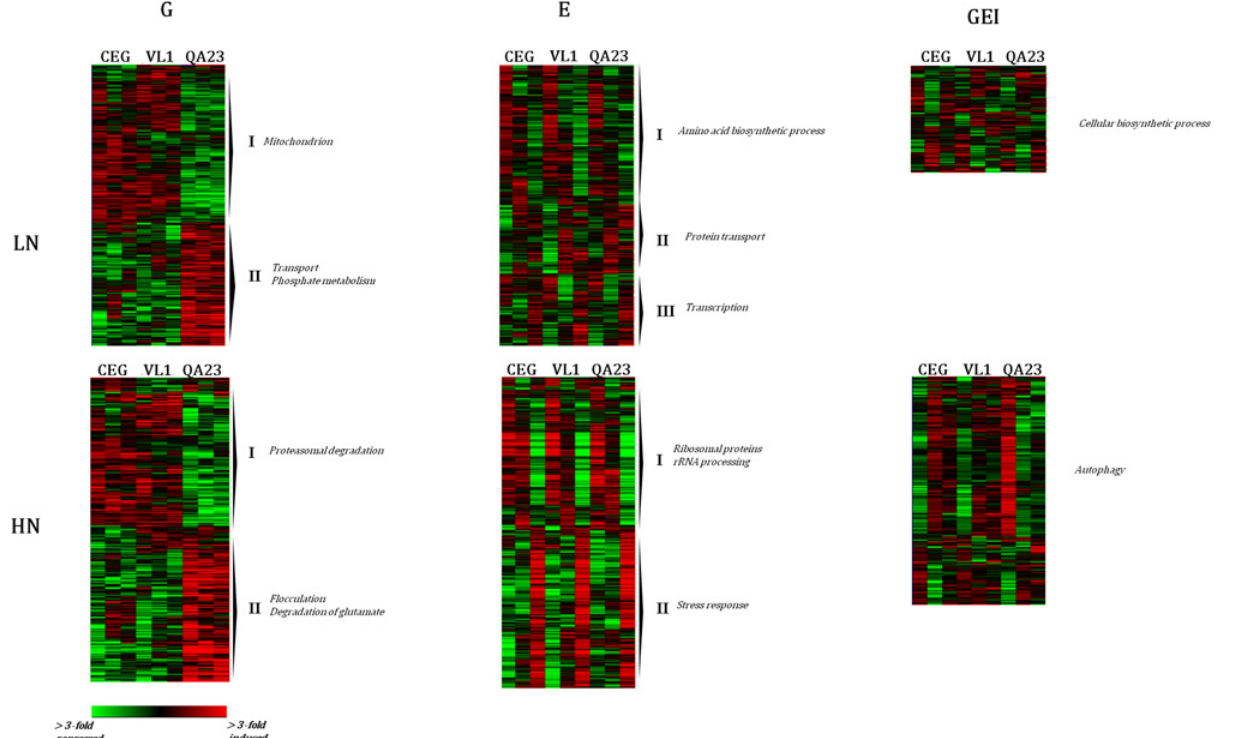
Fig 3. Hierarchical clustering of genes identified as exhibiting significant genotype (G), environmental (E), and gene-by-environment (GEI) effects in each of the fermentations (LN and HN). The diagrams show the log2 expression differences in the indicated strains compared to the mean expression of that gene in all strains in each fermentation. Each row represents a given gene and each column represents a different strain within which expression is ordered by fermentation stage (12, 24 and 96h). Red and green correspond to higher and lower expression, respectively. Clusters are annotated at the right with characteristic GO category functional enrichments (S2